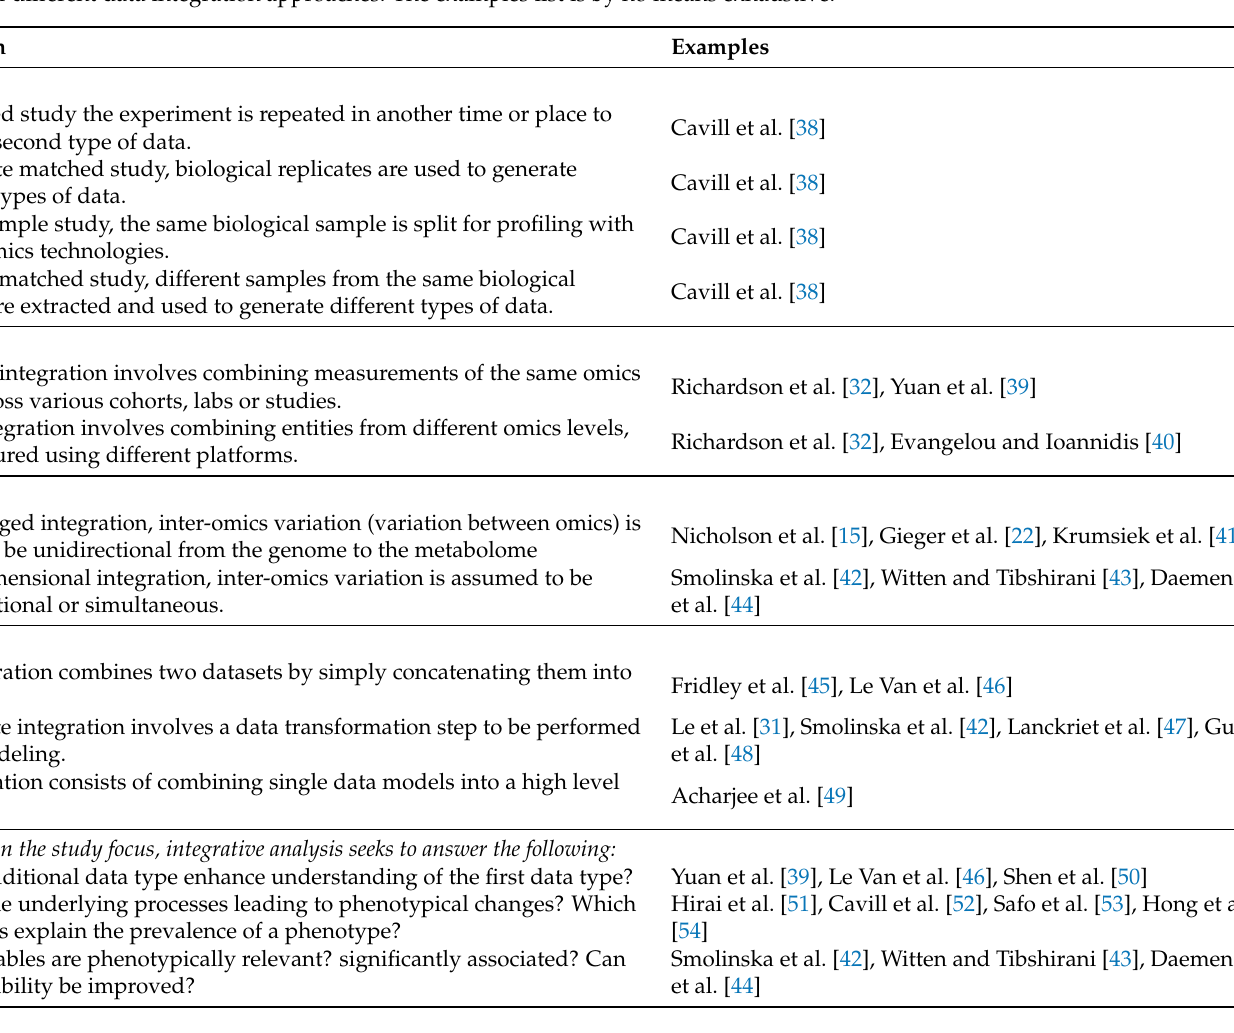
Table 1. Classification of different data integration approaches. The examples list is by no means